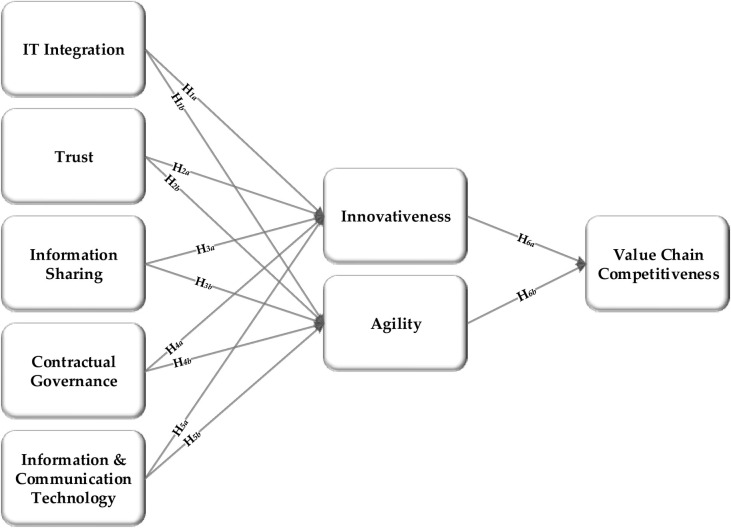
Conceptual model.